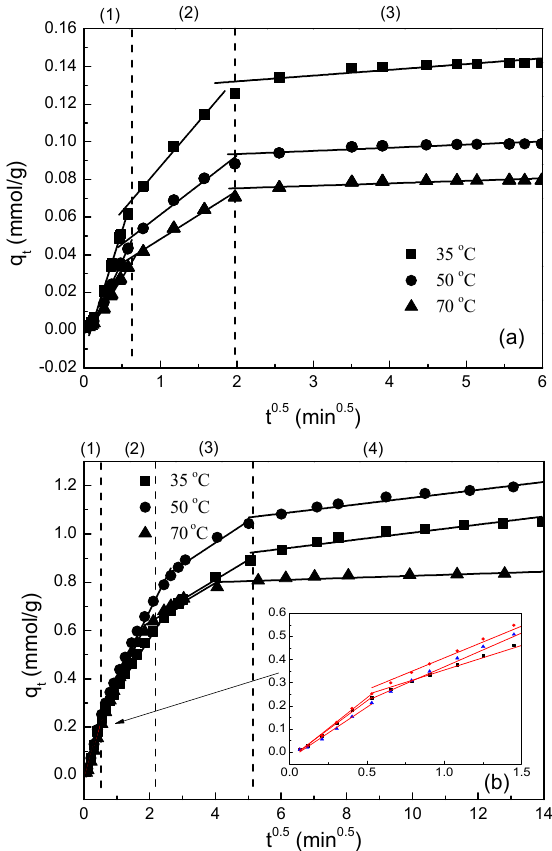
Figure 4. Plots of Weber–Morris intraparticle diffusion model for CO 2 adsorption on ( a ) mesoporous MCM-41 and ( b ) MCM-41-TEPA at 35, 50, and 70 °C.